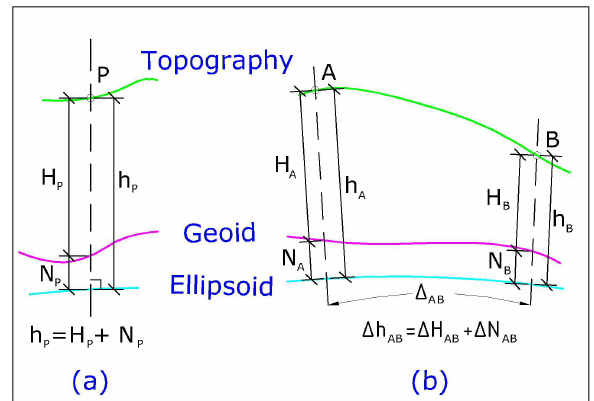
Figure 1: Relationship between ellipsoidal height ( h ), normal- orthometric AHD height ( H ) and geoid-ellipsoid separation ( N ) for (a) absolute and (b) relative GNSS